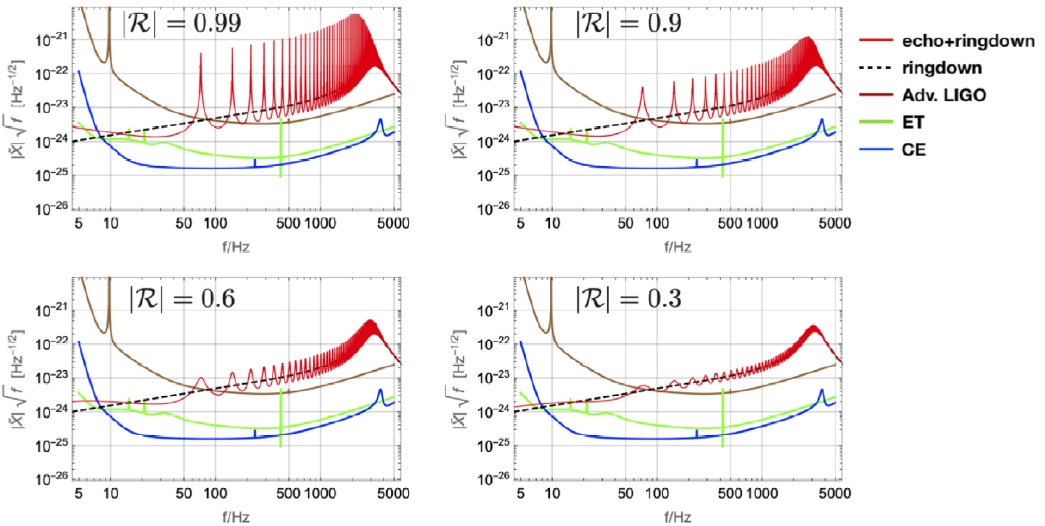
= 0.99, 0.9, 0.6, and 0.3. |R| , θ = 20 ◦ , and (cid:101) rd = (cid:12)